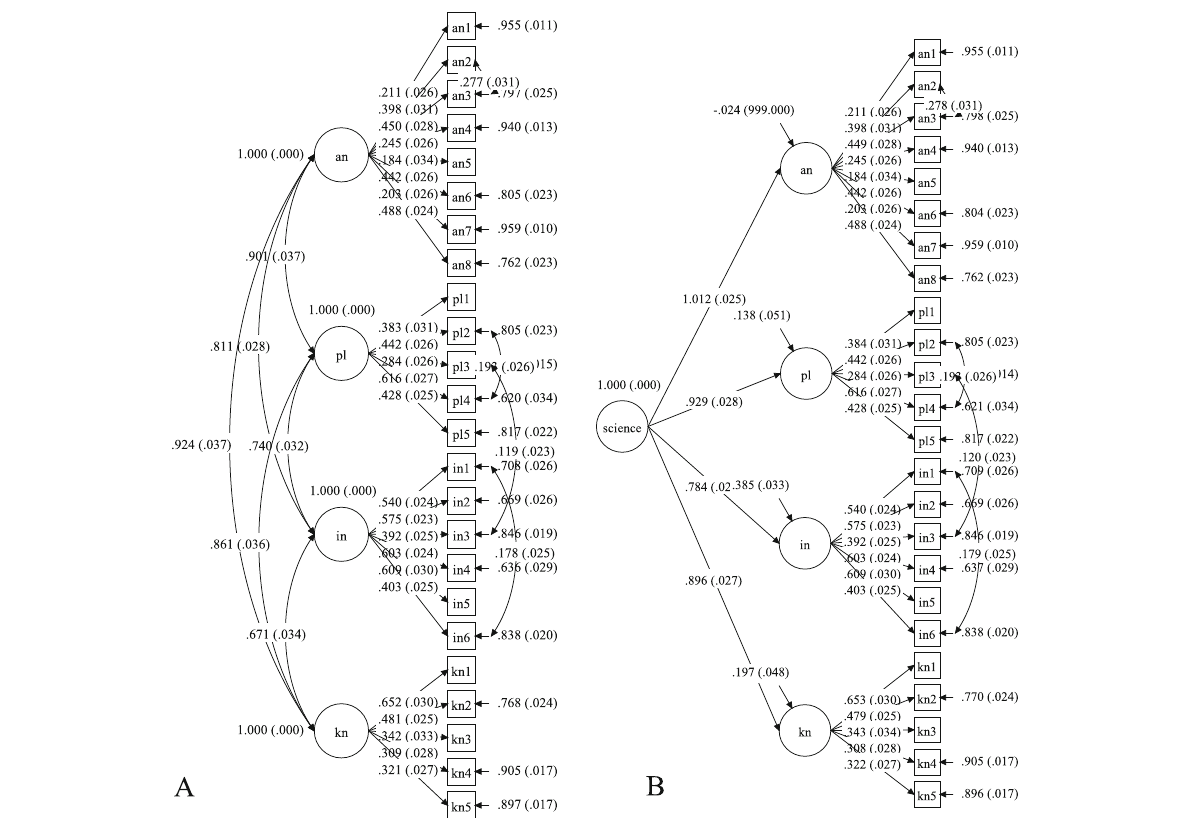
Fig. 4 Correlated factor model ( a ) and second-order factor model ( b ) describing the science inquiry. Correlated factor model ( a ) describing the four factors of analytical skills (An), planning skills (Pl), interpretation skills (In), and science knowledge (Kn) and second-order factor model ( b ) describing the general science competence factor (science) and first order factors describing analytical skills (An), planning skills (Pl), interpretation skills (In), and science knowledge (Kn). The model was created using the data of 24 items of the SIT-PE test ( n =